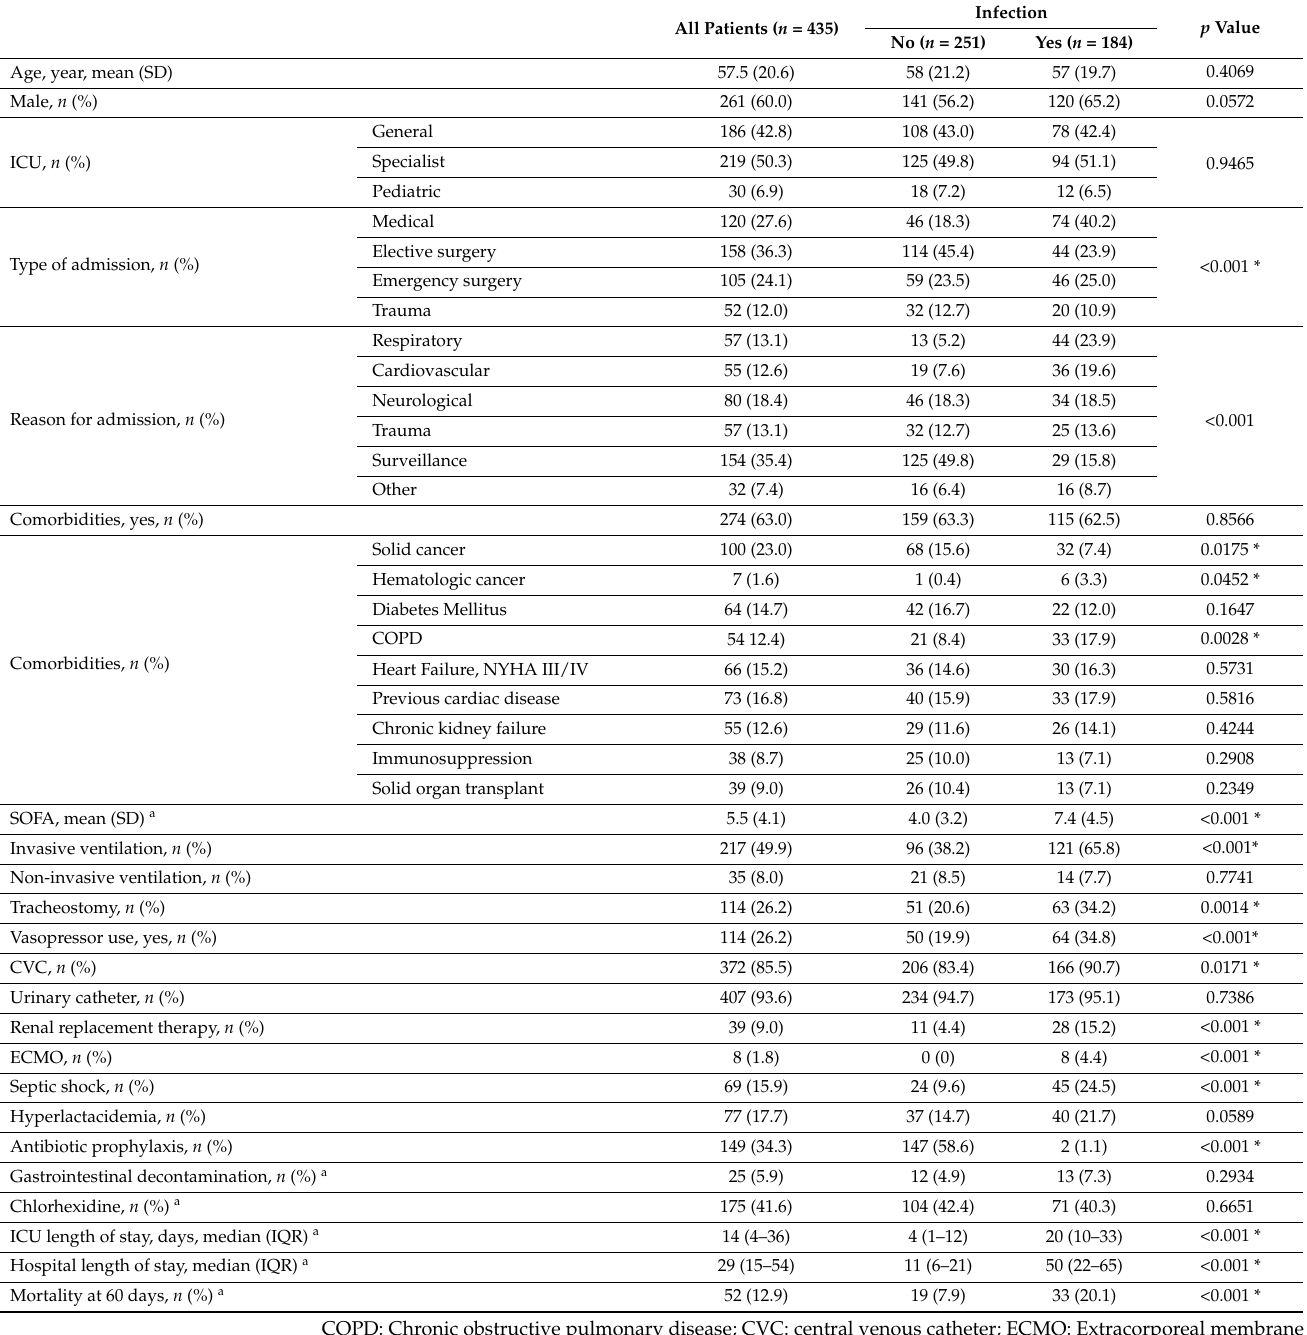
Table 1. Characteristics of patients according to the presence of